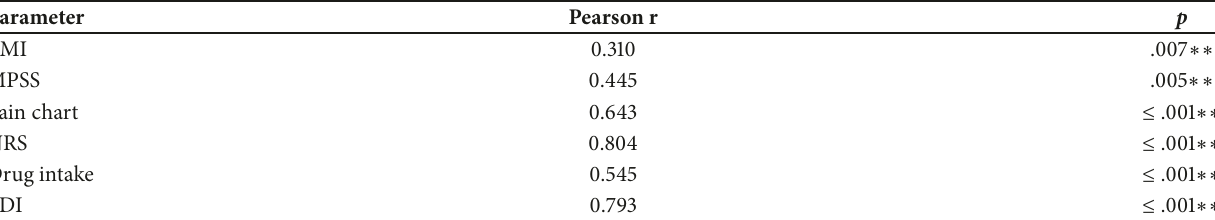
Table 3: Correlations with the